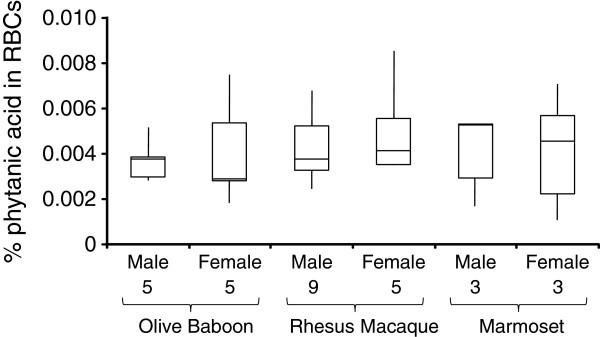
Phytanic acid levels in NHP RBCs by sex. Box plots representing the percentage of phytanic acid relative to total fatty acids from RBCs are provided from male and female olive baboons, rhesus macaques, and common marmosets. Median, quartile 1, quartile 3, minimum, and maximum values are provided. The gender, number of individuals successfully analyzed, and species are provided on the X-axis.